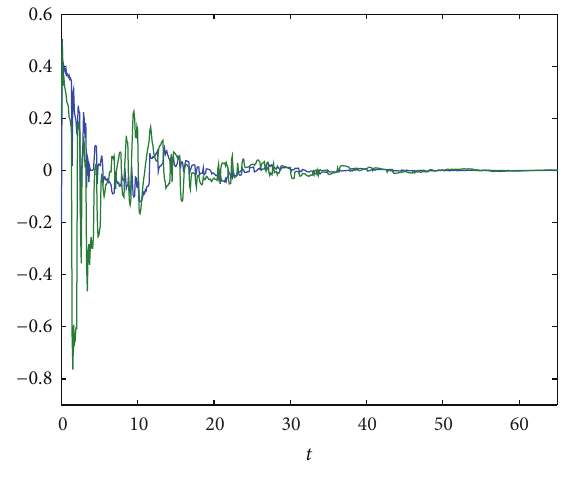
Figure 2: State response of the neural network under the Markov chain depicted in Figure 1 in Example